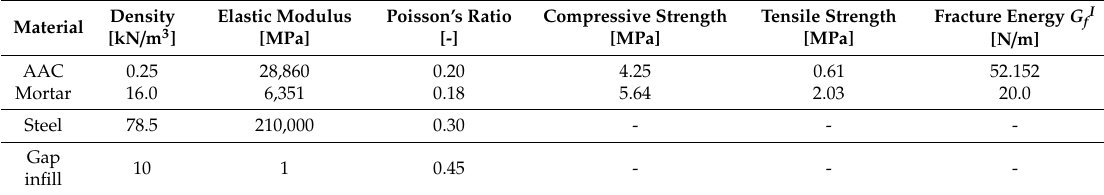
Table 2. Summary of material properties for test specimens